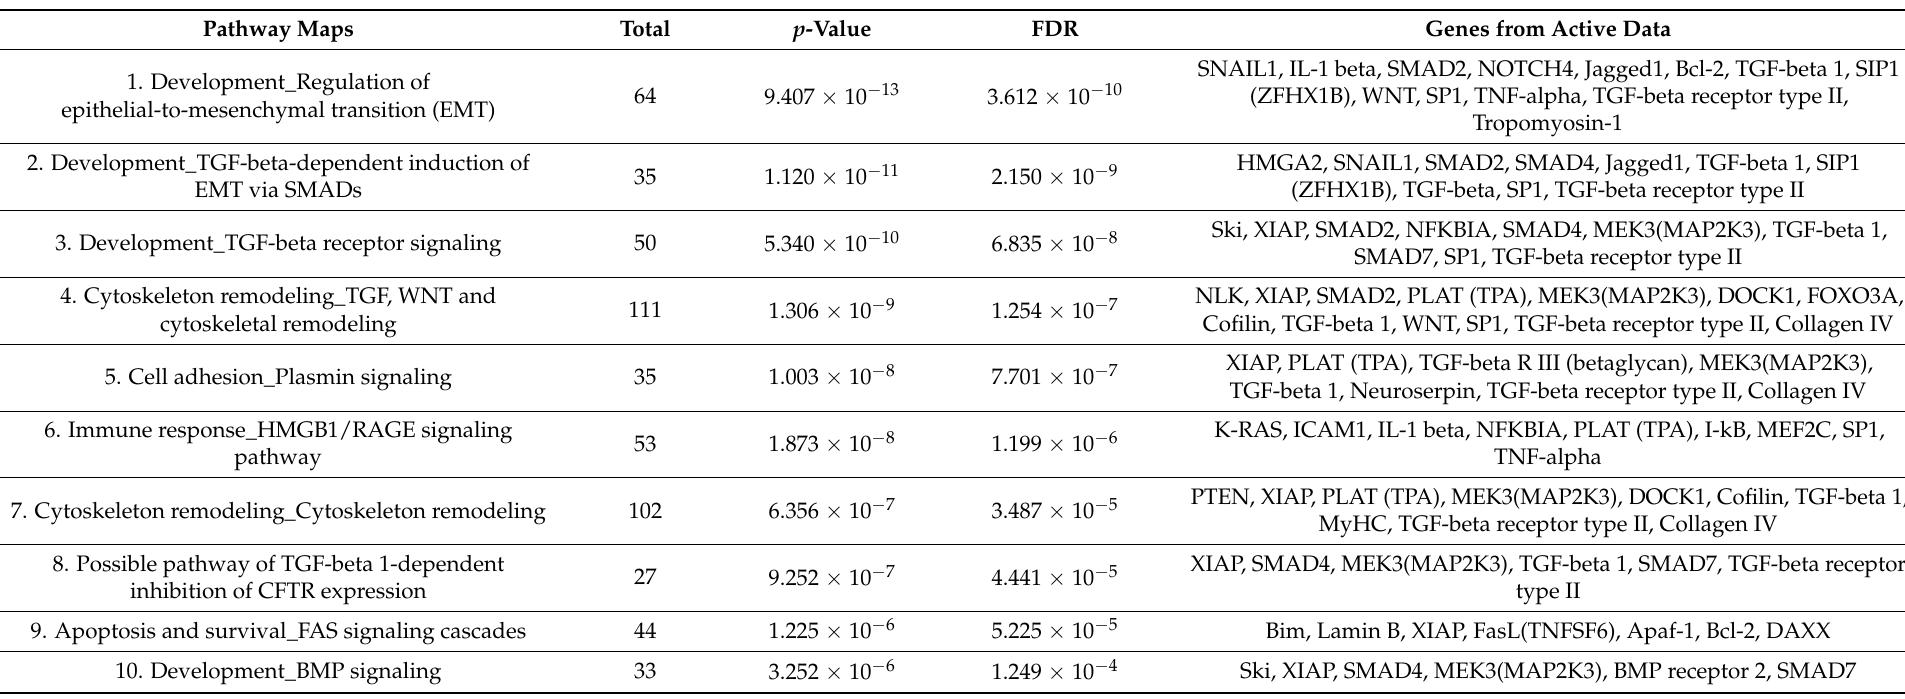
Table 3. Targets of downregulated circulating microRNAs in the plasma of patients with KD were involved in canonical pathway